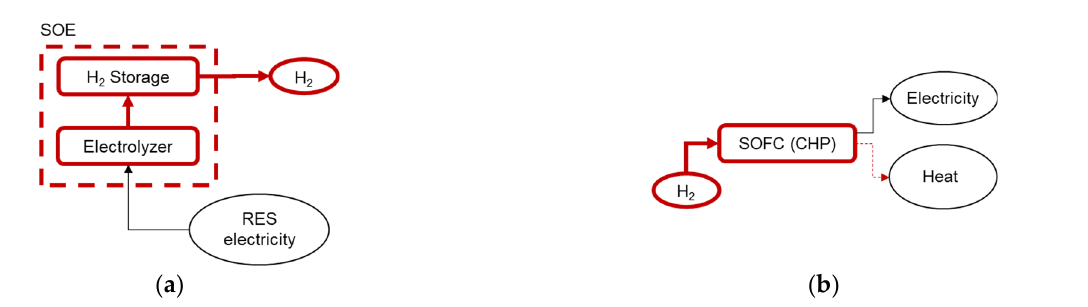
Figure 2. r-SOC working diagram used for the optimization model: ( a ) SOE mode; ( b ) SOFC mode.